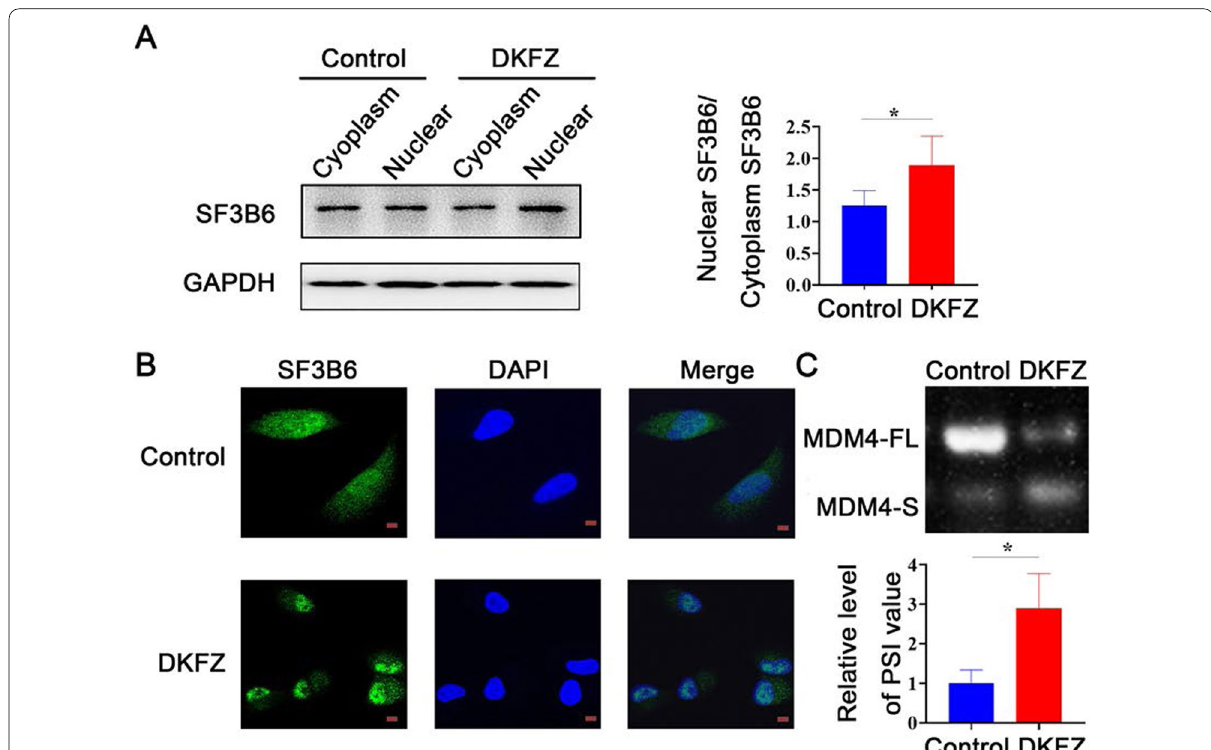
Fig. 6 DKFZp434J0226 (DKFZ) increases the nuclear localization of SF3B6. A Western analysis and quantification of nuclear and cytoplasmic SF3B6 in control and DKFZ-overexpressed AsPC-1 cells. Nuclear and cytoplasmic subcellular fractions were extracted as described in “Materials and methods” section. B Protein levels of SF3B6 in the nucleus and cytoplasm observed using confocal microscope. C DKFZ regulates alternative splicing of SF3B6 downstream MDM4. The alternative spliced transcripts (MDM4-FL, MDM4 full-length transcript; MDM4-S, MDM4 S transcript) in control and DKFZ-overexpressed AsPC-1 cells were verified by RT-qPCR. The percent spliced in index (PSI) was quantified for the alternative splicing events (n 5). A , C Data are shown as mean SD; * P < 0.05, ** P < 0.01. Scale bars refer to 20 = ± SF3B6 is required in DKFZp434J0226 ‑induced cell analysis using DKFZp434J0226 -overexpressed and con- proliferation and migration trol cells. In DKFZp434J0226- overexpression AsPC-1 To study whether DKFZp434J0226 increases cell migra- tion and proliferation via SF3B6, we knocked down SF3B6 in DKFZp434J0226 -overexpressed AsPC-1 and CFPAC-1 cell lines. We found that DKFZ-induced cell proliferation was rescued by SF3B6 knockdown, as evi- denced by the results of the cell growth curve assay (Fig. 7A and (Additional file 2: Fig. S2A), soft agar colony formation assay (Fig. 7B and (Additional file 2: Fig. S2B), and western blotting of PCNA (Fig. 7C and (Additional file 2: Fig. S2C). In addition, SF3B6 silencing inhibited DKFZp434J0226 overexpression-induced cell migration, as measured by migration invasion assays (Fig. 7D and (Additional file 2: Fig. S2D). Furthermore, SF3B6 silenc- ing reduced DKFZp434J0226 overexpression-induced alternative splicing of MDM-4 (Fig. 7E and (Additional file 2: Fig. S2E). These results indicated that SF3B6 was necessary for DKFZp434J0226 -induced cell growth and migration.